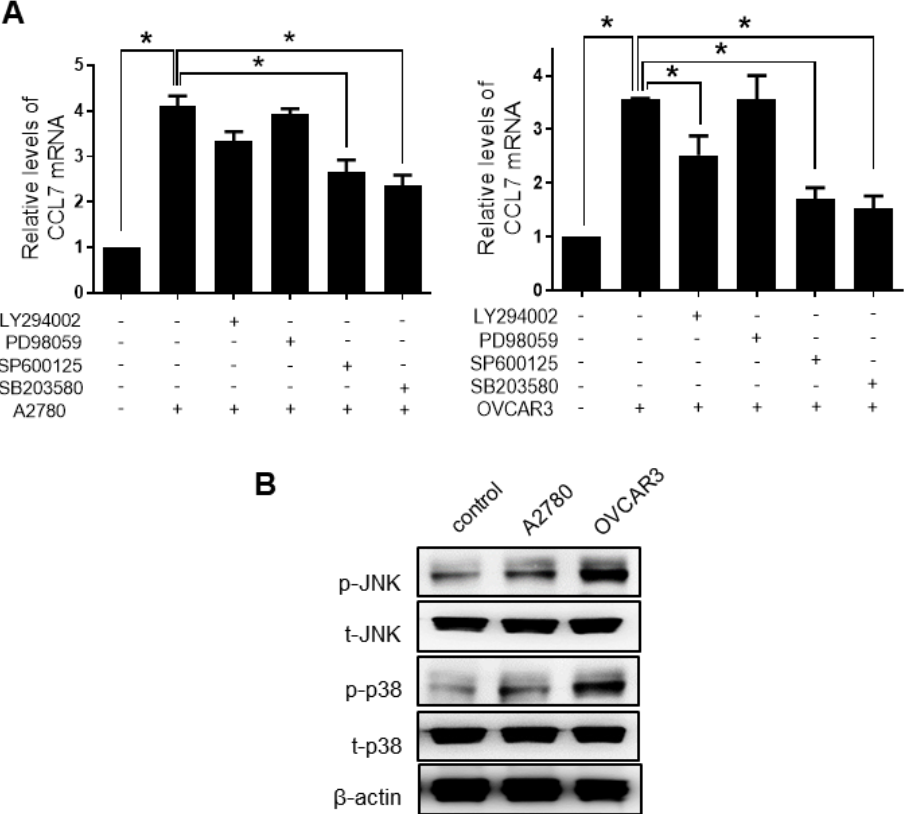
Figure 4. Involvement of p38/c-Jun N-terminal kinase (JNK) signaling in CC chemokine ligand 7 (CCL7) expression in macrophages stimulated by ovarian cancer cells. ( A ) Macrophages were pretreated with PI3K inhibitor, LY294002 (20 µ M), MAPK/ERK Kinase (MEK) inhibitor, PD98059 (70 µ M), JNK inhibitor, SP600125 (20 µ M), or p38 inhibitor, SB203580 (20 µ M), for 1 h, then treated with the CM of A2780 and OVCAR3 cells for 24 h. The mRNA levels of CCL7 were measured by the real-time polymerase chain reaction. ( B ) The levels of phosphorylated JNK, total JNK, phosphorylated p38, and total p38 in macrophages (MQ), macrophages stimulated by A2780 cells (A-MQ), and macrophages stimulated by OVCAR3 cells (O-MQ) were analyzed by Western blot assays. Original Western Blots shown in Figure S6. * p < 0.05.